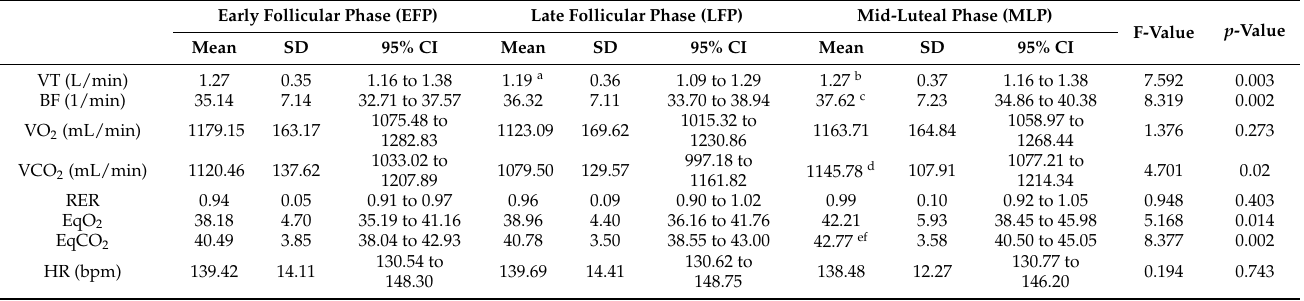
Table 3. Results of ANOVA for repeated measures for phase factor in the cardiorespiratory variables ( n =